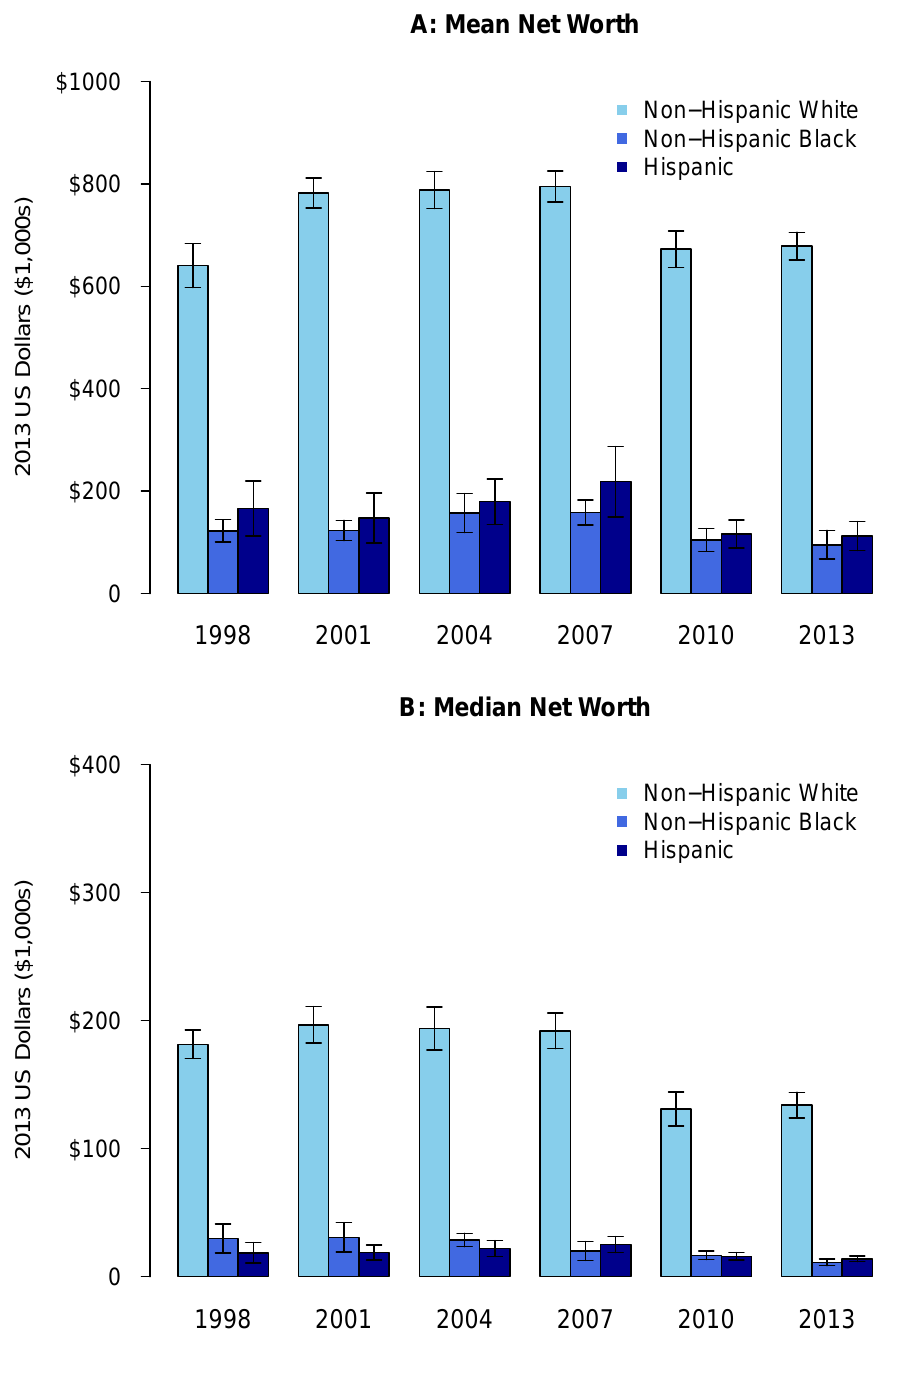
Figure 1: Mean and median net worth by race and ethnicity, 1998–2013. Notes: Figure 1 presents mean and median net worth levels for non-Hispanic white, non-Hispanic black, and Hispanic households in thousands of 2013 U.S. dollars for the 1998–2013 waves of the SCF. The figure includes estimates and 95 percent confidence intervals. sociological science | www.sociologicalscience.com